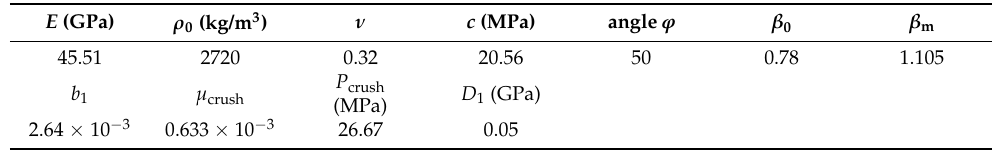
Table 2. The parameters of limestone of deep-metamorphic